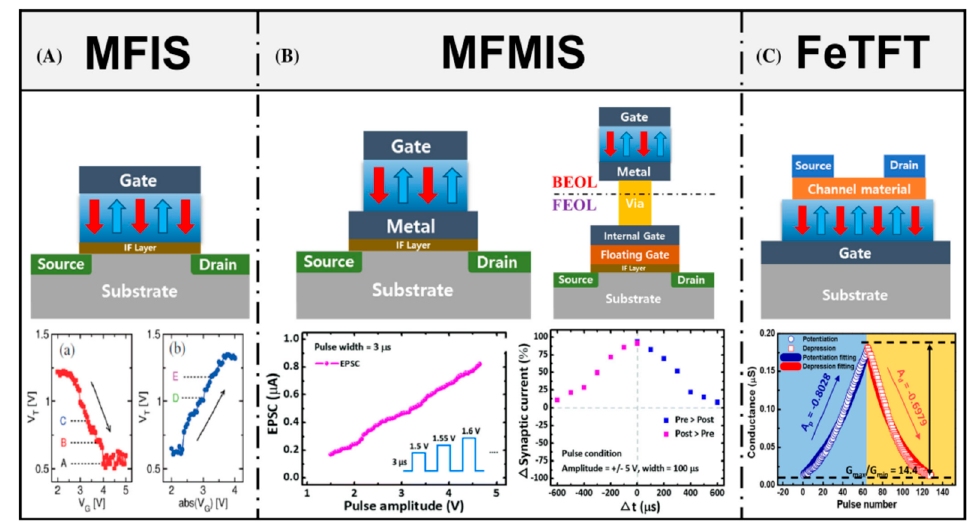
Figure 6. Various ferroelectric devices with a three-terminal structure (upper row) and corresponding characteristics of synaptic plasticity (lower row). ( A ) MFIS, ( B ) (left) MFMIS and (right) MFMIS with the MFM capacitor integrated into the BEOL and the underlying MOSFET integrated into the FEOL, and ( C ) FeTFT. Schematic of FeFETs with different channel geometries and synaptic potentiation (a) or depression (b) [73].